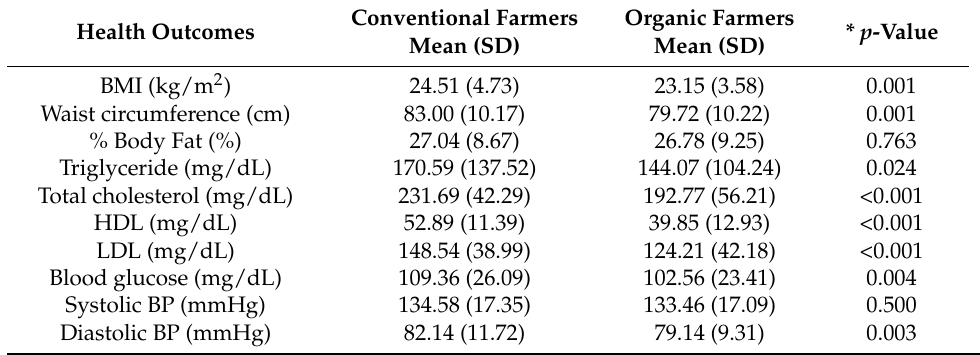
Table 2. Comparison of conventional ( n = 213) and organic farmers ( n = 225) for metabolic biomarkers